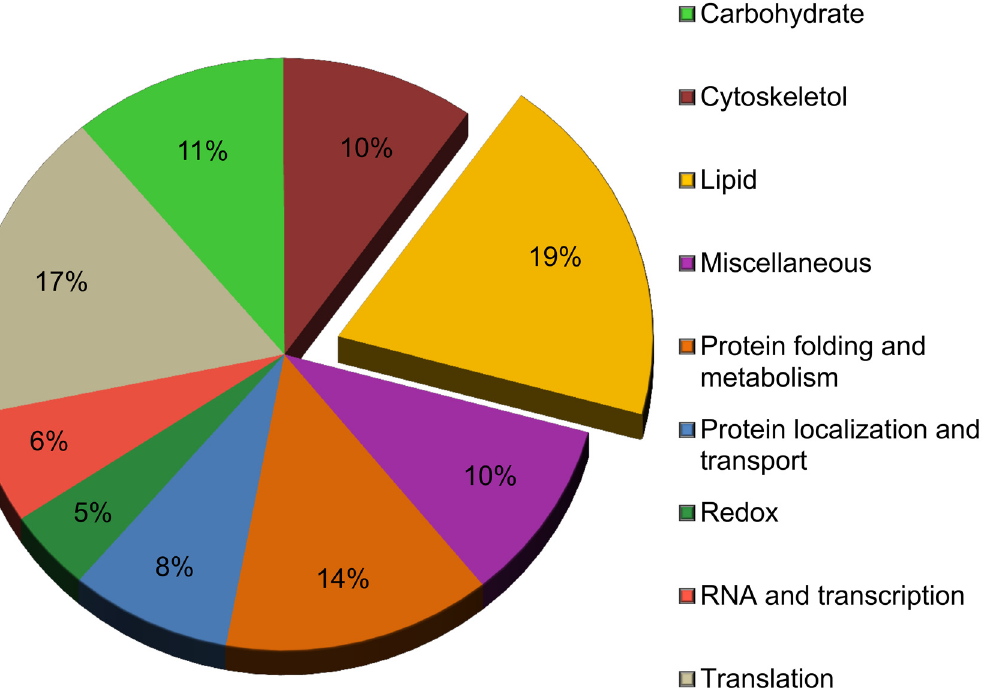
Fig 3. Proteins identified by LC MS/MS and grouped by biological process and molecular function. Identified proteins were assigned to a general classification based on the gene ontology (GO) term for molecular function or biological process using